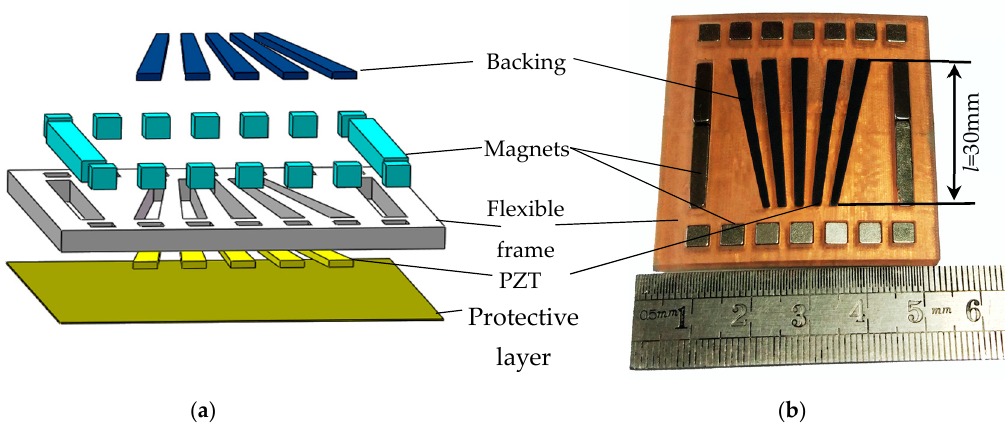
Figure 10. ( a ) Transducer three-dimensional (3D) analog decomposition diagram; ( b ) transducer physical map.